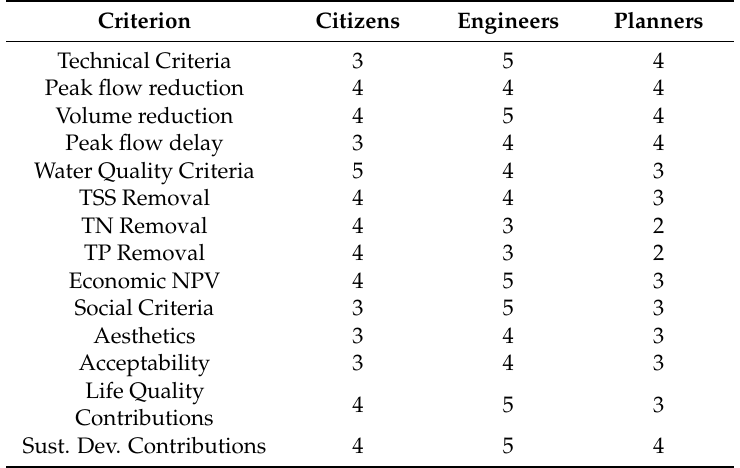
Table 8. Criteria level of importance.